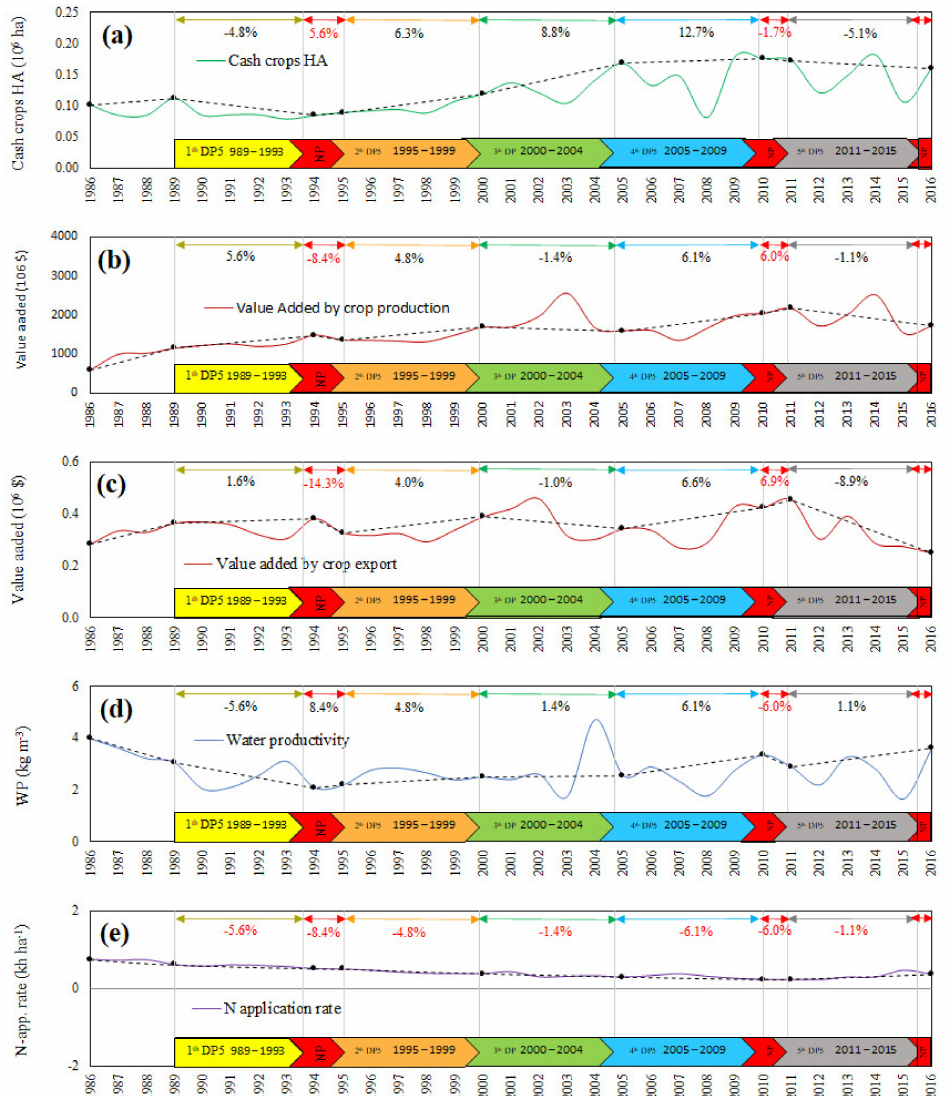
Figure 15. Policy impacts on the evolution of cash crops harvested area (HA) ( a ), value-added by crop production ( b ), value-added by crop export ( c ), water productivity (WP) ( d ), and N-application rate (N-app-rate) ( e ) during first to fifth 5-years development plans (DV5) in the Khuzestan province over the period